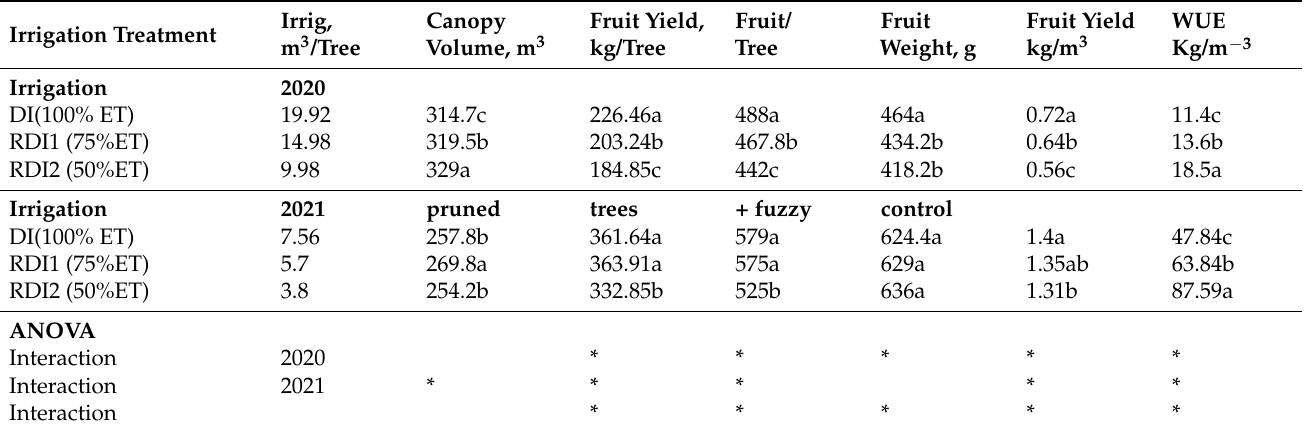
Table 10. Average fruit yield, fruit per tree, fruit weight, water applied, canopy volume and WUE for each irrigation treatment during 2020 and 2021 in mature trees using the fuzzy